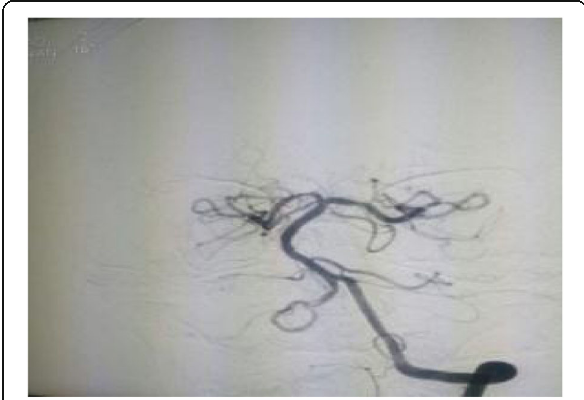
Fig. 2 Intervention phase after stent deployment of Lt VB stenosis in the same patient in Fig.